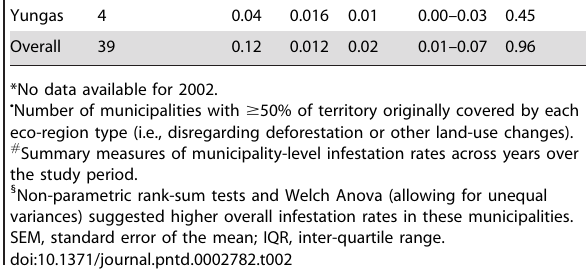
above. We compared model performance using AICc (second- order Akaike information criterion) and BIC (Bayesian informa-